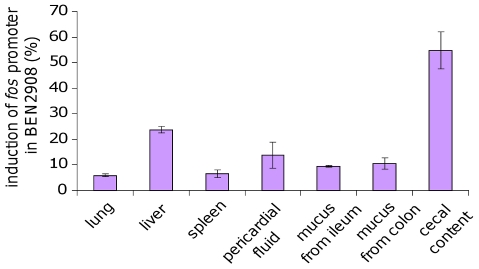
Activation of fos promoter in chicken extracts or physiological fluids.Percentage of fos promoter activation was obtained by dividing the maximum luciferase expression in BEN2908 by the maximum luciferase expression in BEN2908ΔfosR. The average values and standard deviations result from three independent experiments.